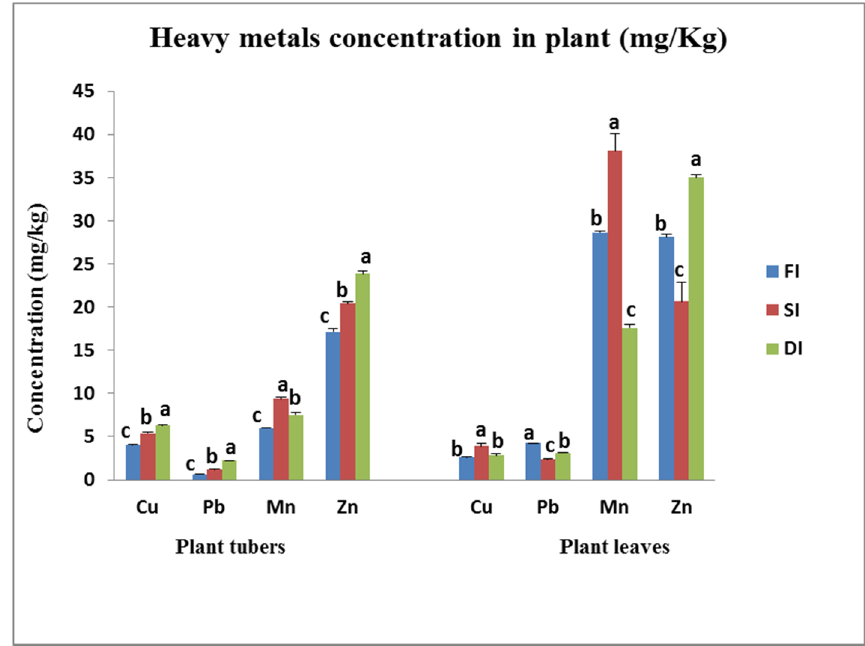
Figure 6. HM concentrations (mean ± SE; mg/kg) in both shoots and tubers of potato plants under different irrigation methods with HM contaminated water. Small letters show significant difference between irrigation methods. Bars with the same letter for the same metal refer to insignificant difference and bars with different letters for the same metal refer to significant difference at p -level < 0.05 according to Duncan’s multiple range test.